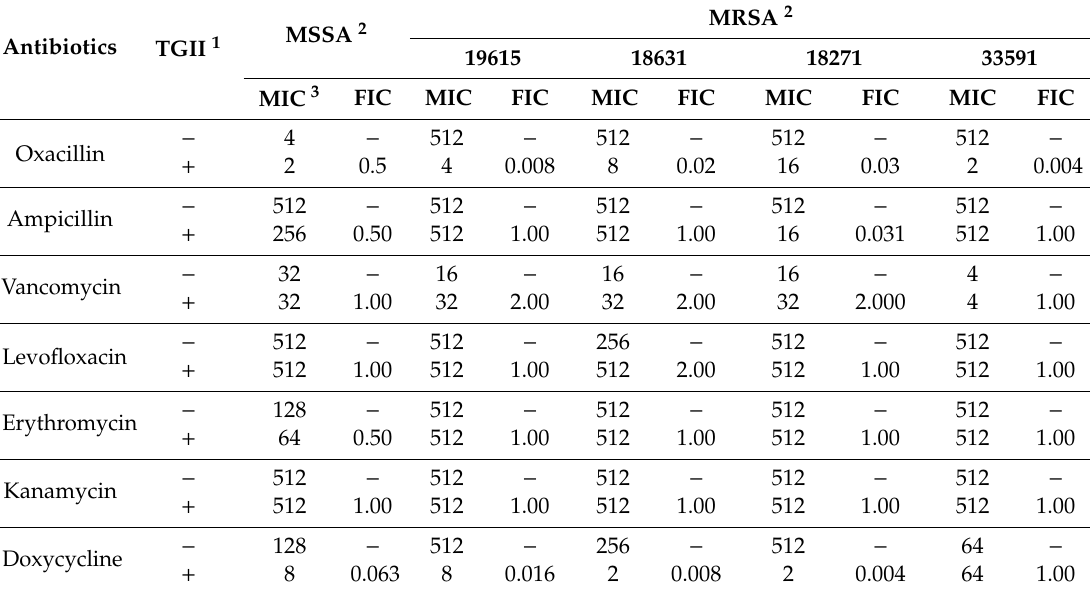
Table 3. MIC and FIC of the conventional antibiotics with or without TGII against MSSA and MRSA.